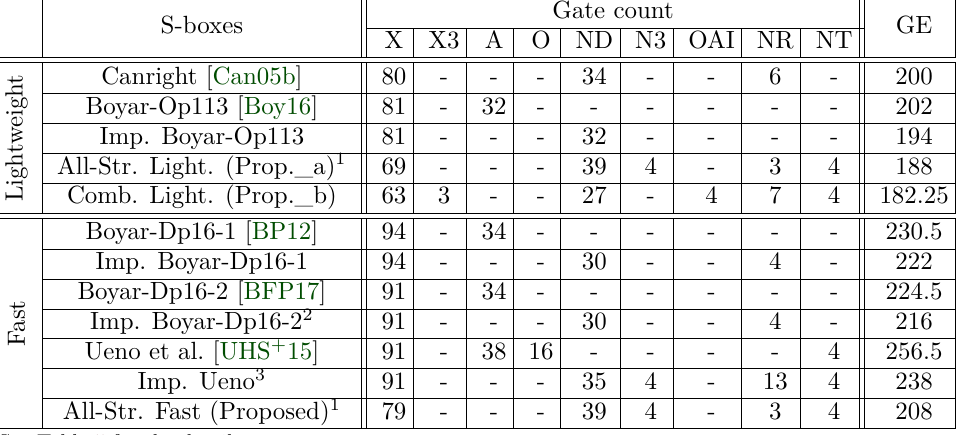
Table 10: Space complexity comparison of different S-boxes (X=XOR2/XNOR2, X3=XOR3, A=AND2, O=OR2, ND=NAND2, N3=NAND3, OAI=OAI32, NR=NOR2,